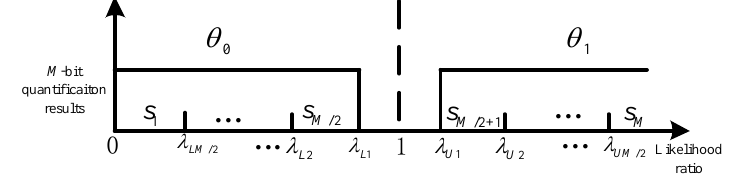
Figure 2. Local multiple-bit quantification. Except for the dormant case, there were 2 M possible cases for the local detection. They were the cases where the decision results were M log { s } under two prior states, respectively. Then, we defined four kinds of de- 1 , s 2 ,..., s M tection probabilities, namely, the local-detection probabilities { P d [ 1, M /2 ]) , the missing-detection probabilities { P false-detection probabilities { P f abilities under a zero prior state { P 0 d